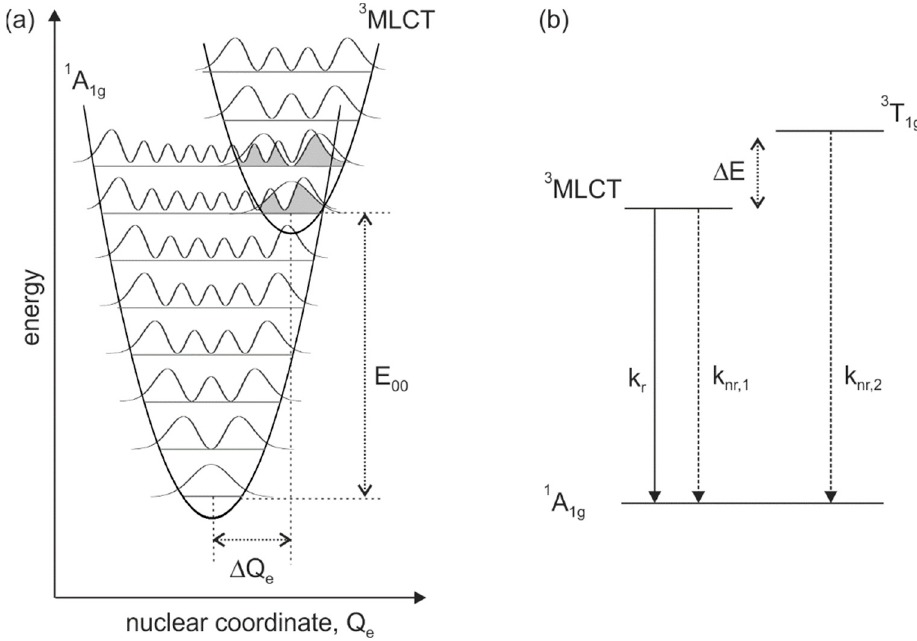
Figure 3. ( a ) Vibrational overlap (gray shaded areas) leading to nonradiative excited-state decay. ( b ) Nonradiative deactivation of the 3 MLCT excited state via thermal population of the 3 T 1g (metal-centered) excited state.